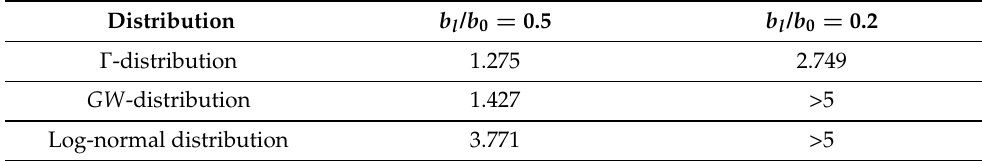
Table 2. Boundary values for the coefficient of variation c ∗∗ to compare strategies l = 2 and l = 3 for 4-out-of-6 : F